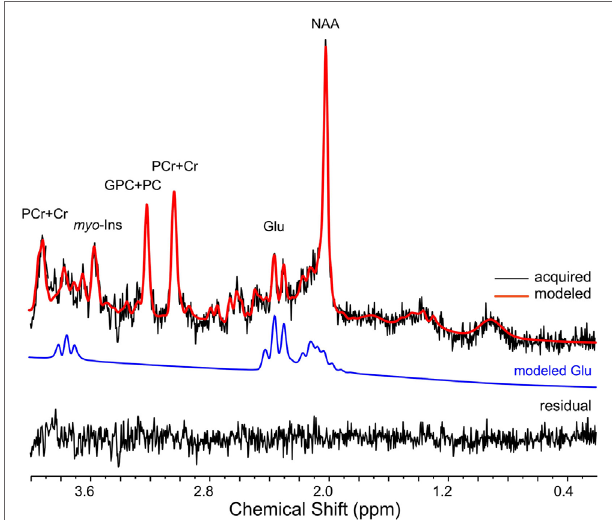
FigUre 5 | A representative 1 H magnetic resonance spectroscopy spectrum is depicted (32s temporal resolution; 8 averages). The raw signal is depicted in black, while the LCModel fit is in red. The isolated glutamate (GLU) signal (blue line) and residual are presented below the spectrum. Chemical shift (ppm) is depicted below the spectrum. NAA, N-acetyl-aspartate; PCr + Cr phosphocreatine plus creatine; GPC + PC, glycerophosphocholine plus phosphocholine; myo -Ins, myo